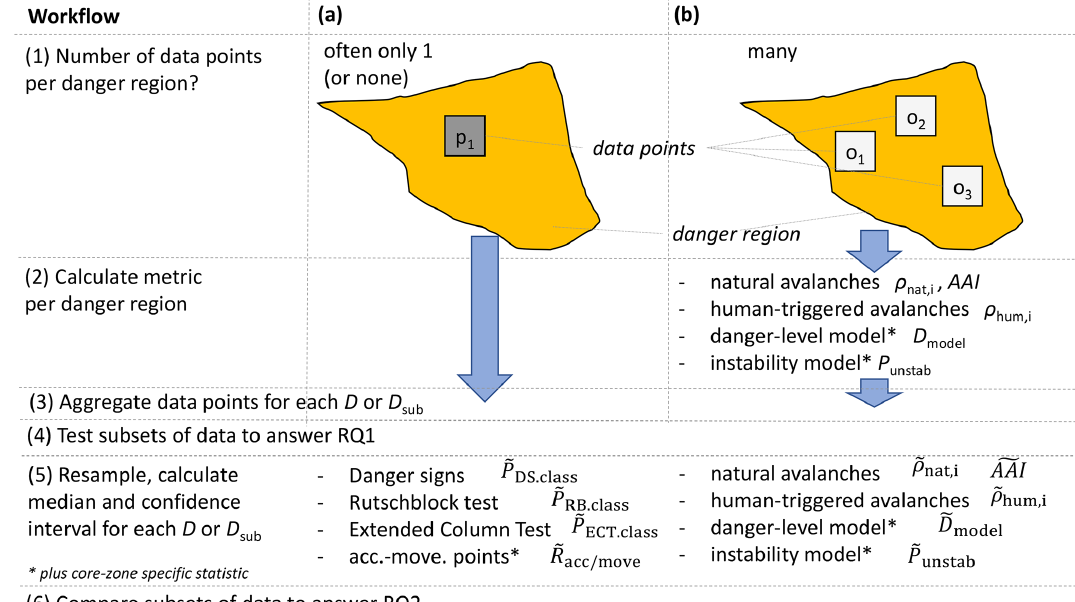
Figure 4. Workflow: preparatory steps (steps 1 to 3) and analysis to answer research question 1 (step 4) and 2 (steps 5 and 6).